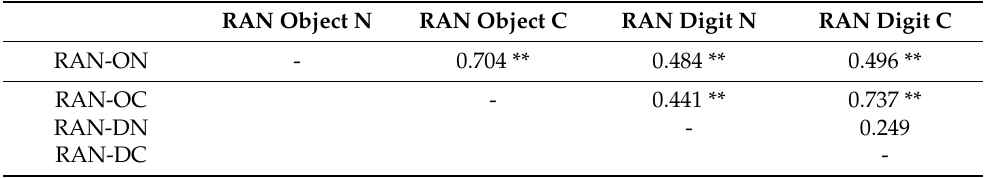
Note: ** p < 0.01. Table 11. Pearson’s correlations of eye movement time recorded across all the RAN-related tasks. RAN Object N RAN Object C RAN Digit N RAN Digit C